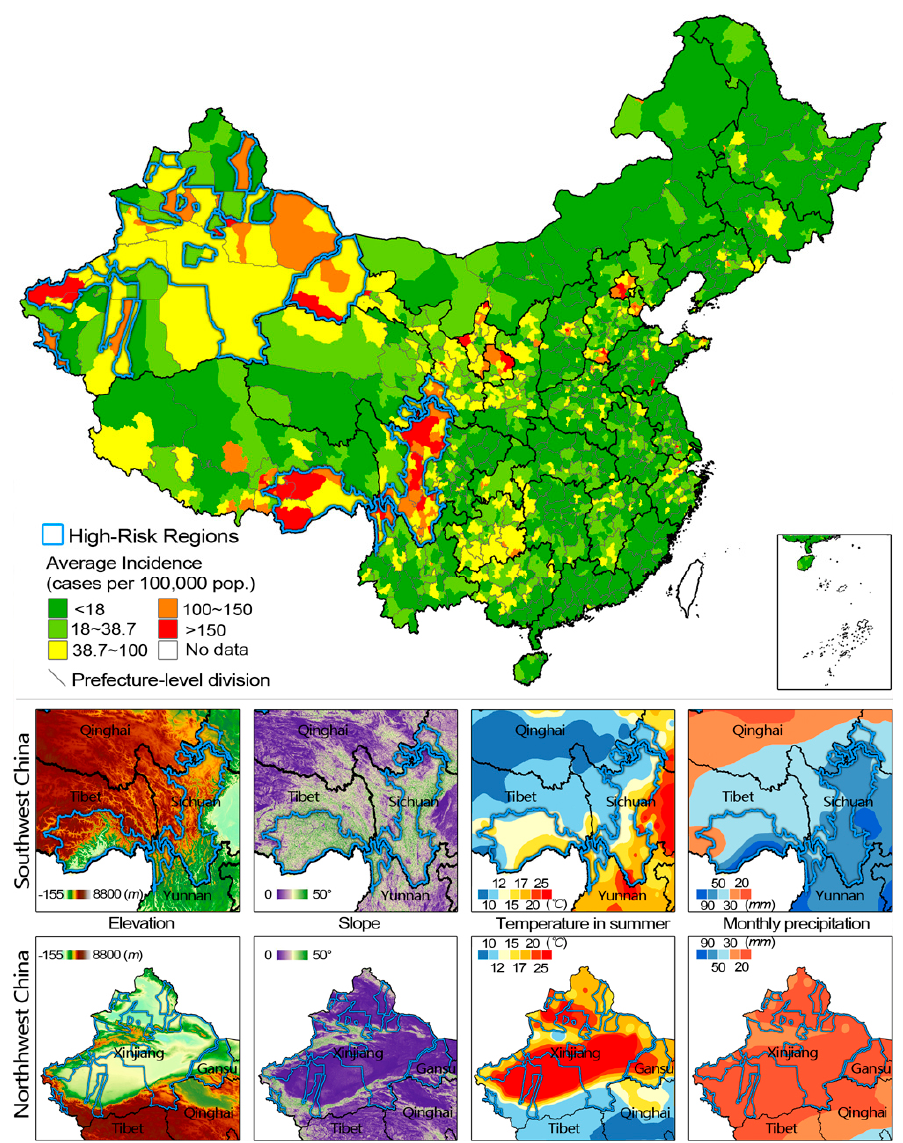
Figure 3. Endemically high-risk regions in southwest and northwest China and relevant environmental factors. Map was drawn at county-level and the color blocks represented annual average incidence of bacillary dysentery during 2005–2010. The two high risk regions in western China are marked in blue. Gray line: boundary of municipality cities, prefecture-level cities, autonomous prefectures, prefectures and leagues. The maps were created using the ArcGIS 10.0 software (ESRI Inc.).